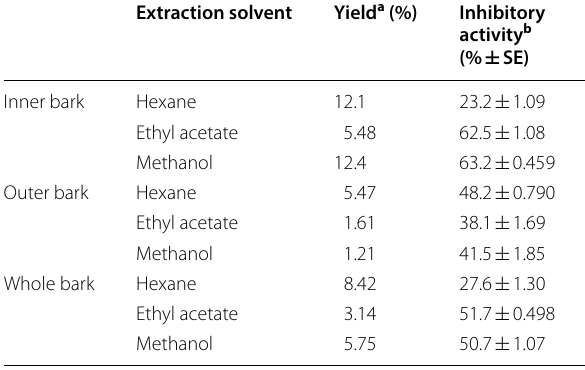
Table 1 Yields and growth inhibitory activities of successive extracts obtained from sugi bark